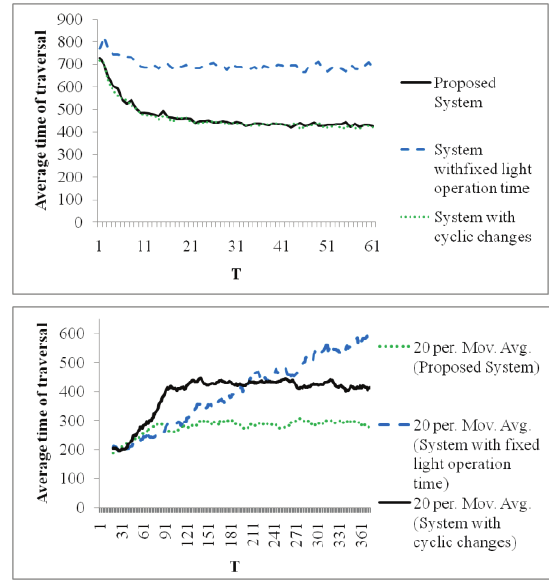
Fig. 2.Comparative analysis of traffic lights system for different values of T (a) Densely occupied scenario (b) Lightly occupied